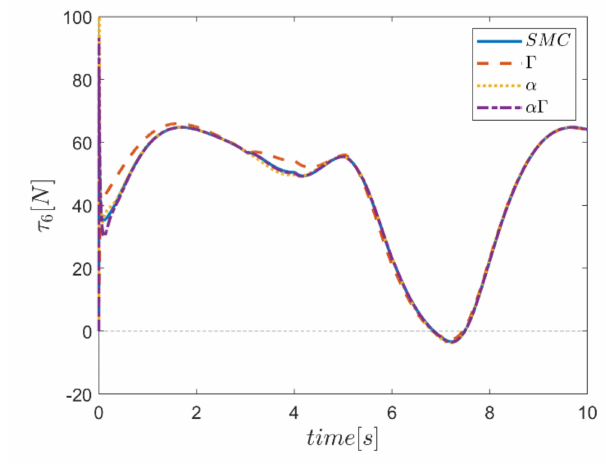
Figure 33. Comparison of the input force in the sixth actuator.